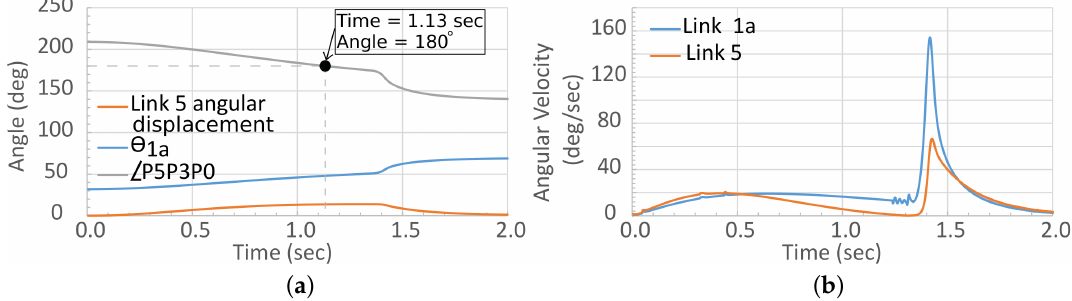
Figure 18. Kinematics of links 1a and 5 ( a ) angular displacement; ( b ) angular velocity.